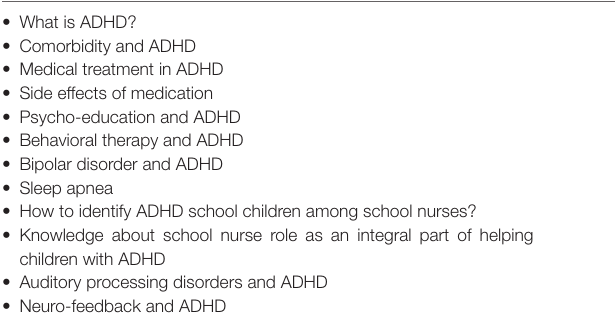
TABLE 3 | Review of consensus of nurses working with children and adolescents with